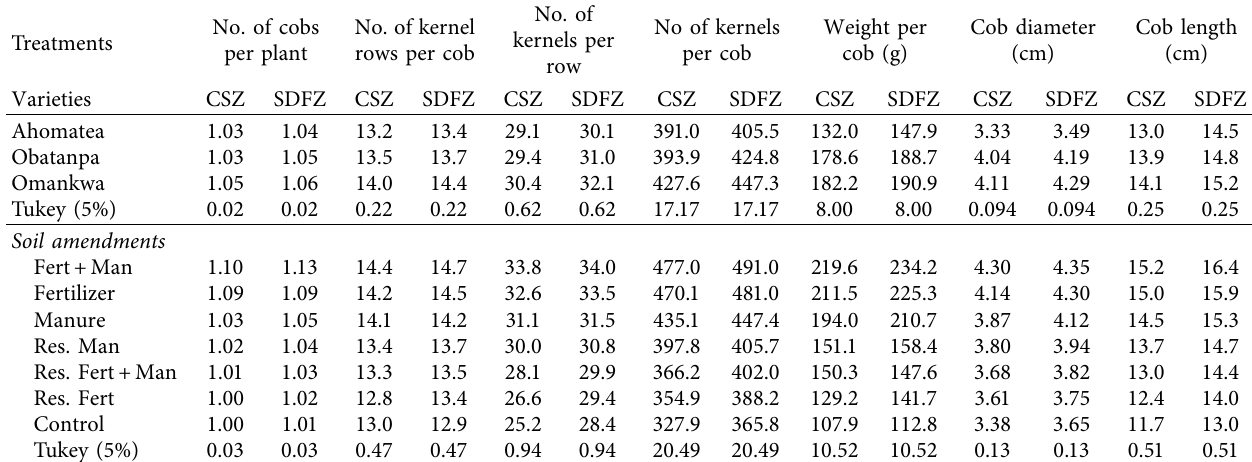
Table 9: Yield components of three maize varieties as infuenced by residual efects/application of soil amendments in the coastal savannah zone (CSZ) and semi deciduous forest zone (SDFZ) in the minor cropping season. Treatments